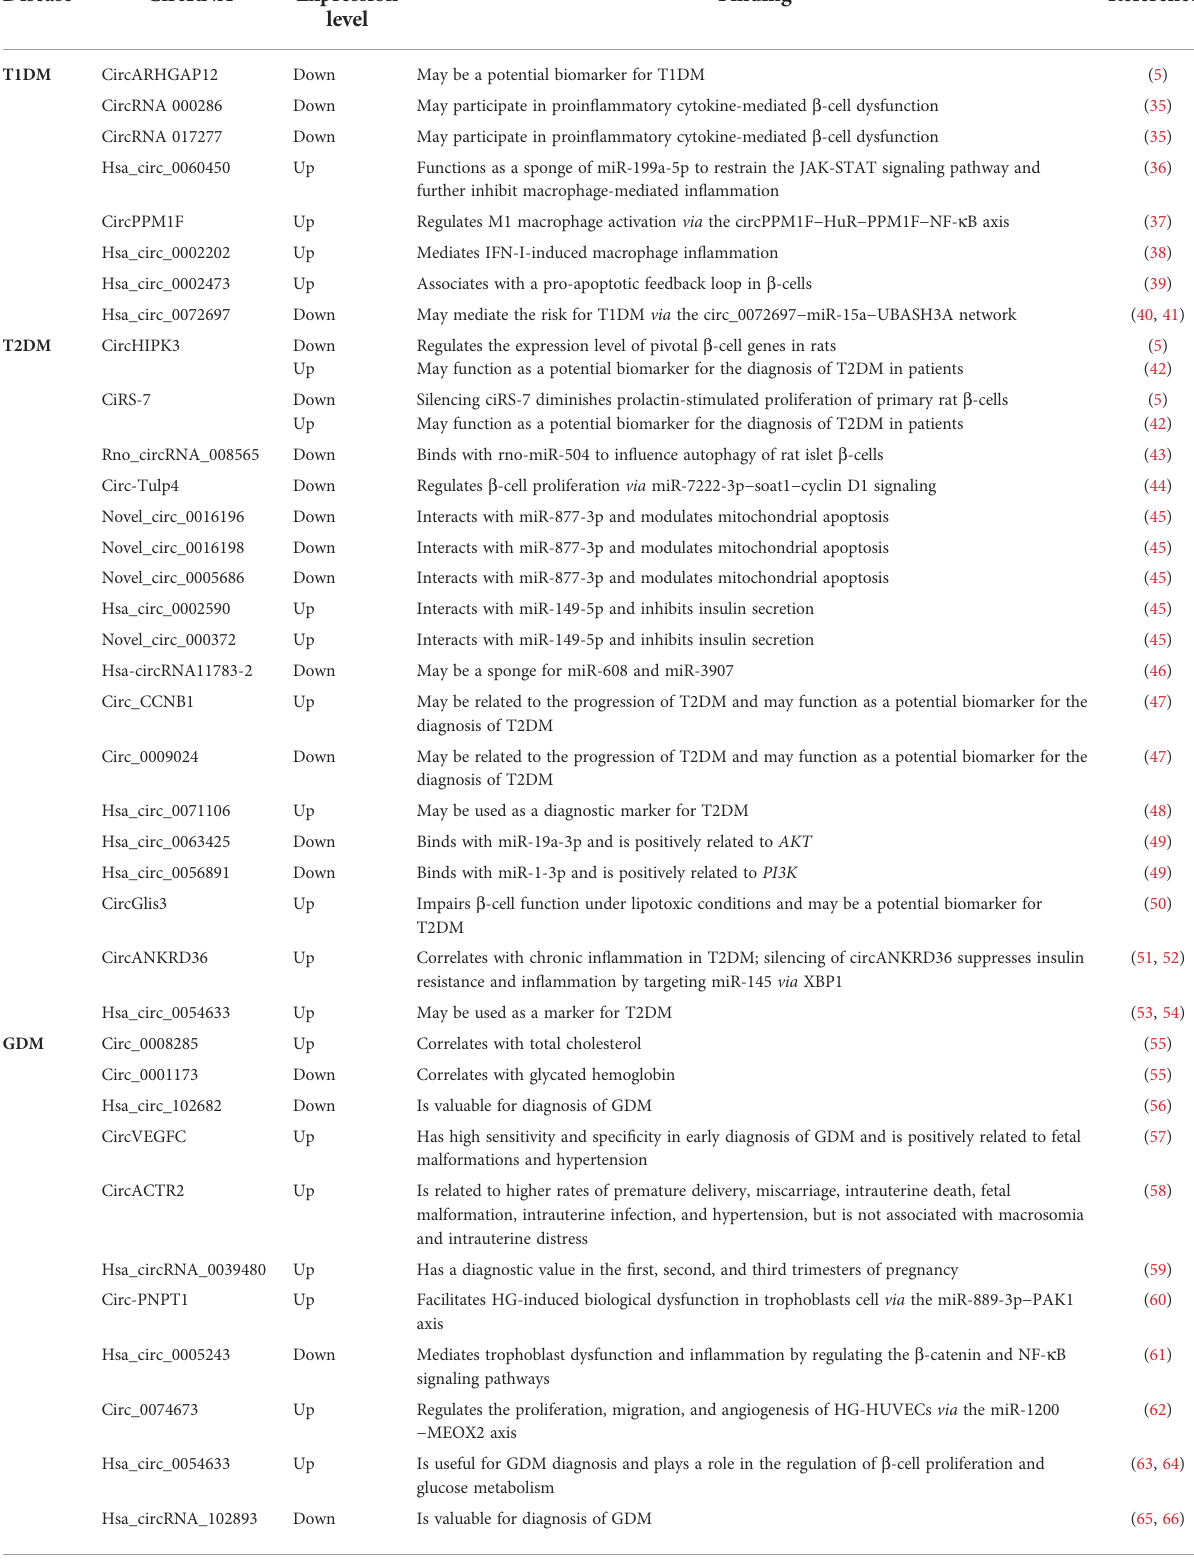
TABLE 1 Role of circRNAs in DM and associated complications.